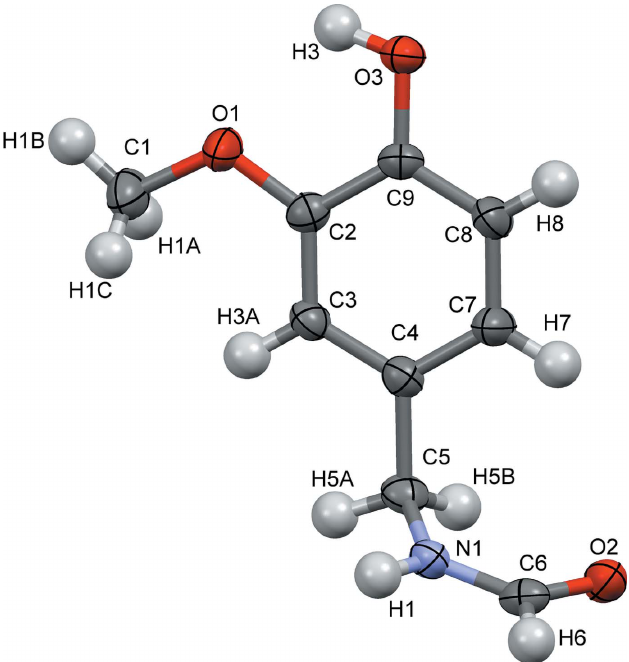
Figure 2 The molecular structure of compound ( II ), showing the atom-labelling scheme. Displacement ellipsoids are drawn at the 50% probability level. H atoms are shown as fixed-size spheres of 0.30 A˚ .